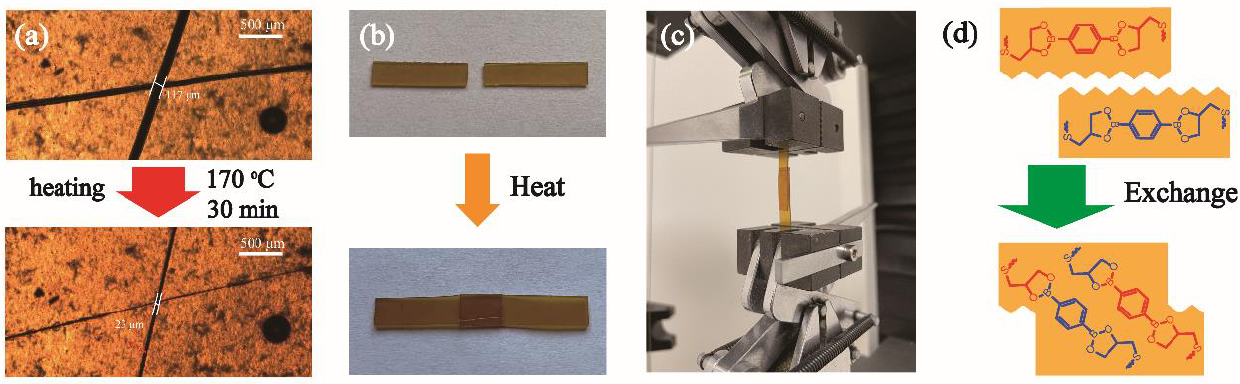
Figure 8. ( a ) Optical microscope images of self-healing performance for 20%C-FPEA. ( b ) Optical microscope images of welding performance. ( c ) Photograph of a sample during the lap-shear test. ( d ) Schematic representation of the transesterification reaction of boronic ester linkages.